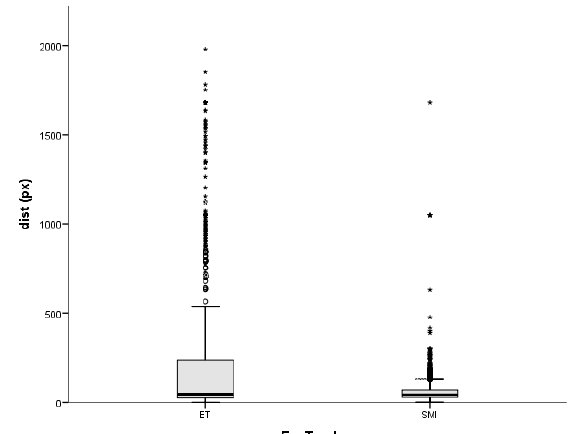
Figure 9: Boxplots of the registered offset values for both eye tracking devices. Offset values illustrate the accuracy of the fixation location with the Eye Tribe tracker (ET, left) and the SMI RED 250 (SMI, right). The distribution of these values is linked to precision of the recordings.